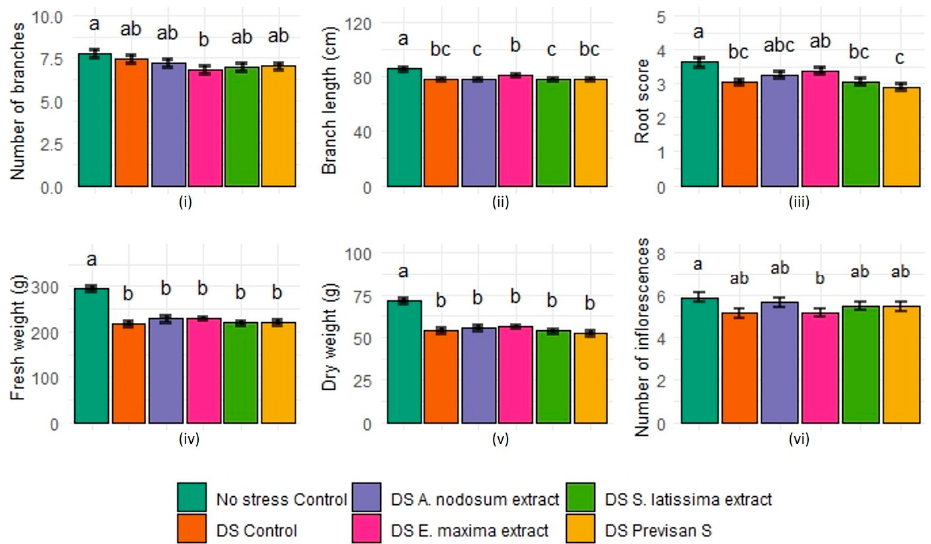
Figure 5. Effects of repeated drying cycles without (DS Control) and with biostimulants on plant quality traits compared with optimal irrigation (No stress Control): ( i ) number of branches, ( ii ) length of the longest branch, ( iii ) root development score, ( iv ) fresh and ( v ) dry weight, and ( vi ) total number of inflorescences. Results of branch length and dry weight were analyzed by a two-way ANOVA followed by a Tukey HSD test. Other results were analyzed by a Scheirer–Ray–Hare test combined with a Dunn’s test. Different letters (a, b and c) per parameter indicate a significant difference at p ≤ 0.05 (Mean ± SE; n = 56).